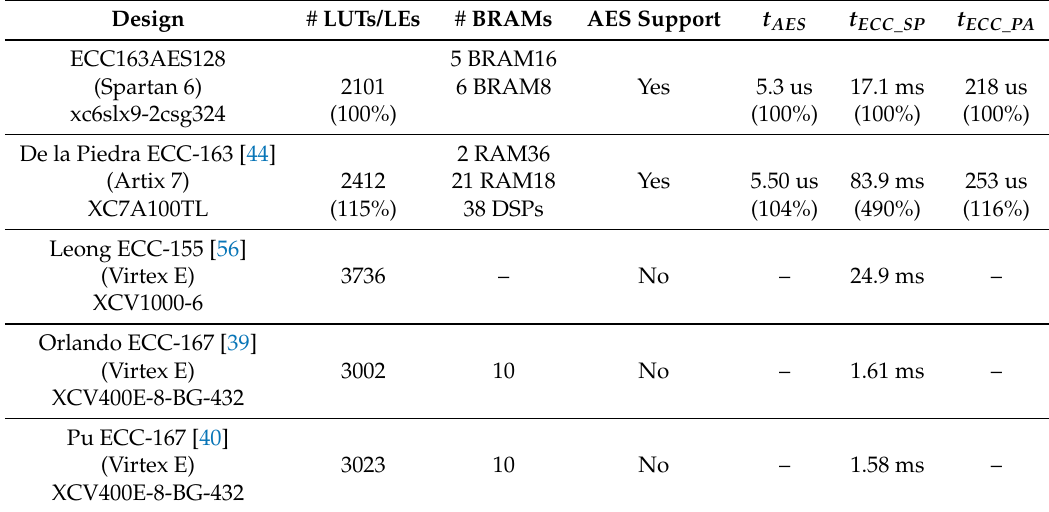
Table 6. Comparison of ECC163AES128 to other compact cryptoprocessors.